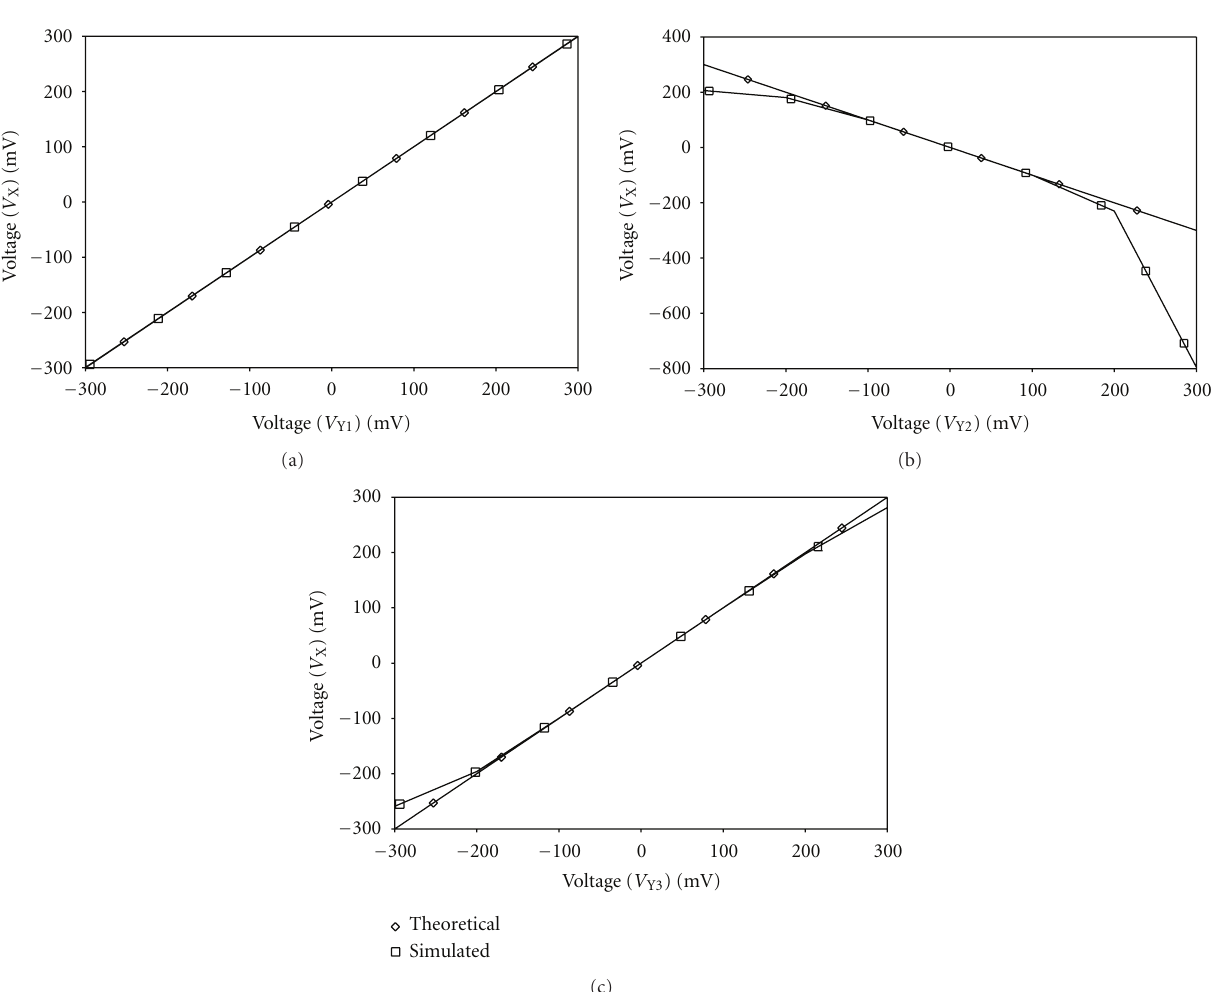
Figure 3: DC transfer characteristic for voltage transfer from (a) Y 1 port to X port, (b) Y 2 port to X port, and (c) Y 3 port to X port.